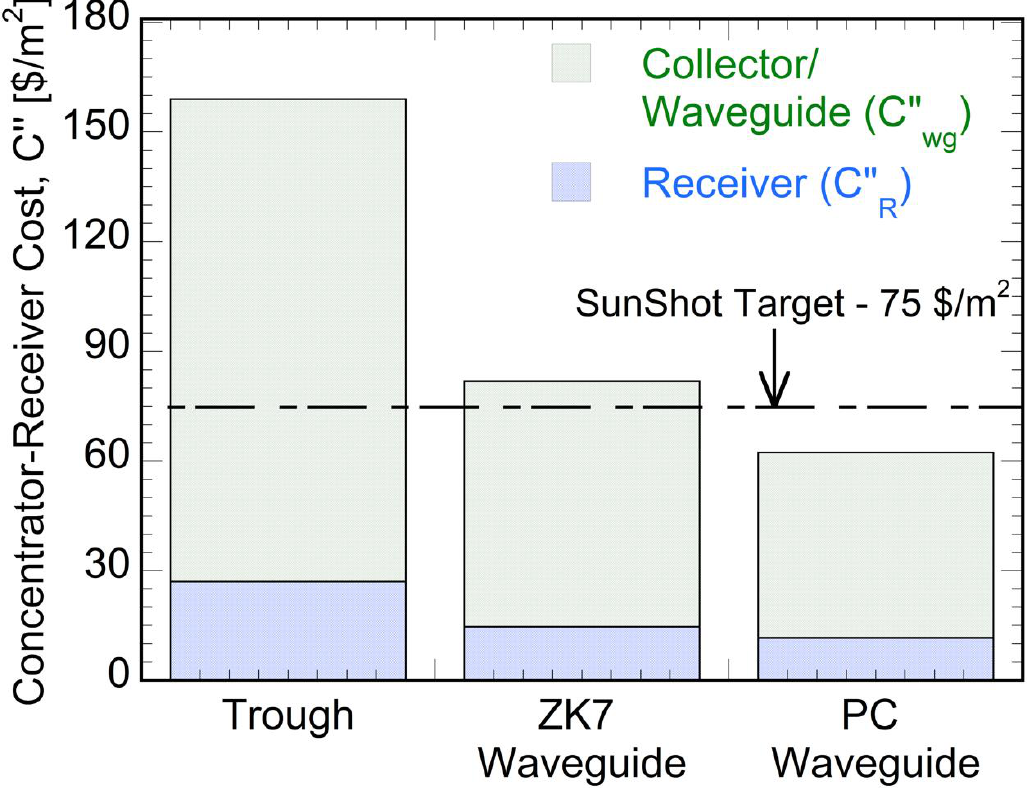
Figure 11. Comparison of solar concentrator-receiver cost per unit aperture area for hexagonal waveguide made of ZK7 glass and polycarbonate polymer against state-of-the-art parabolic troughs.